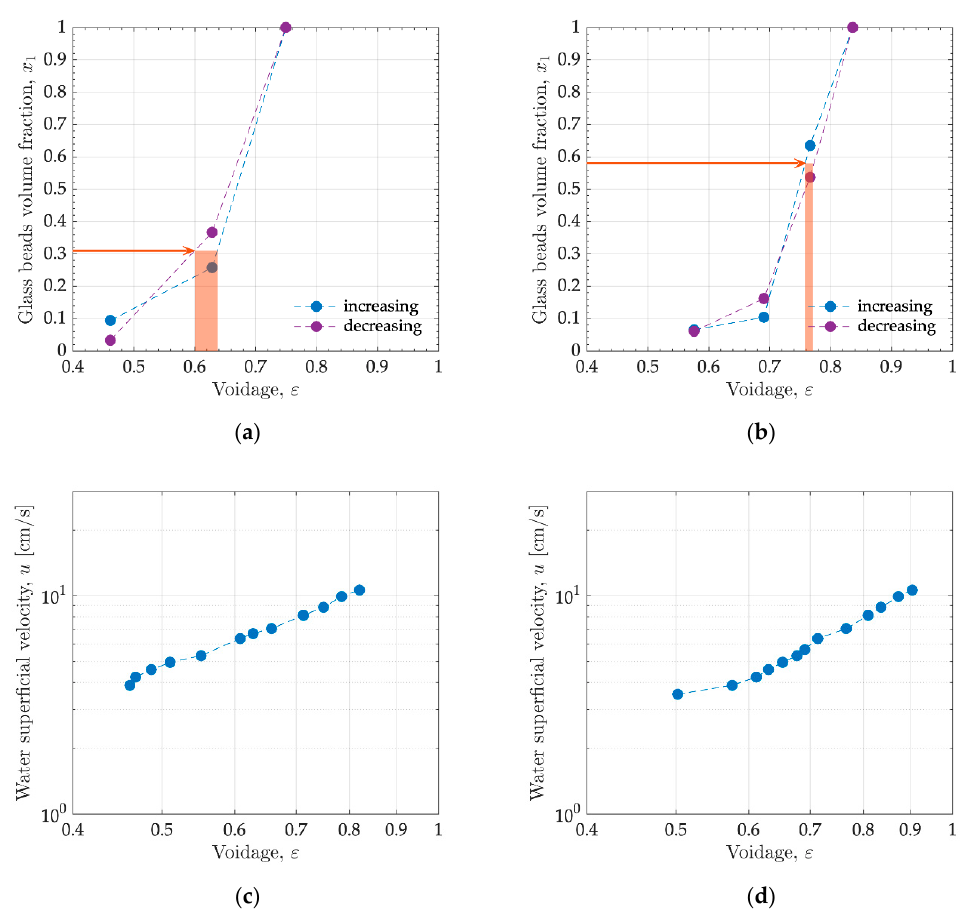
Figure 8. Determination of the experimental inversion voidage average and uncertainty range and mixture expansion characteristics. Example of the concentration of the uppermost layer as a function of the voidage for the system GB1_PS1_X1_0.31 ( a ) and GB1_PS1_X1_0.58 ( b ), corresponding velocity–voidage relationships ( c ) and ( d ), respectively.